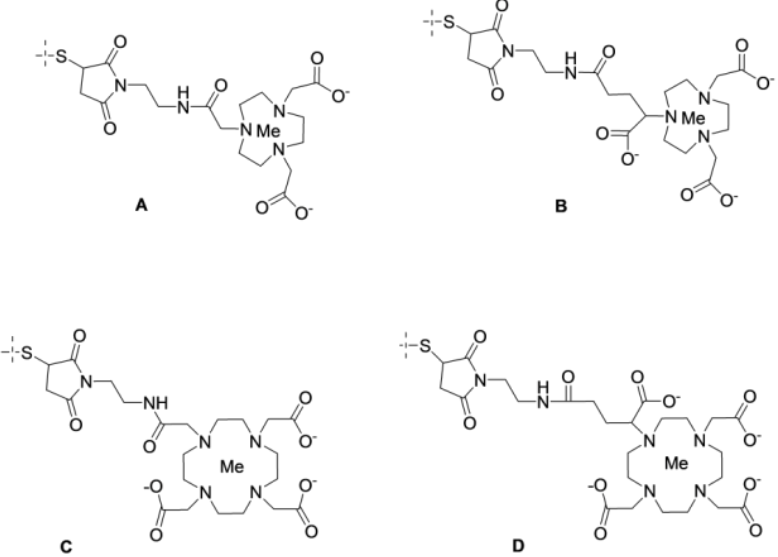
Figure 7. Macrocyclic chelators NOTA ( A ), NODAGA ( B ), DOTA ( C ), and DOTAGA ( D ) conjugated to cysteine using maleimido derivatives.